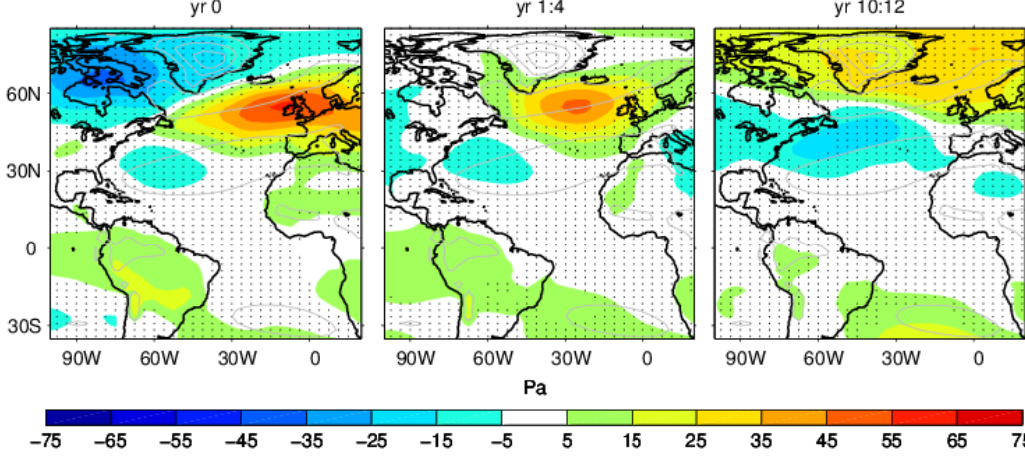
Fig. 8. Composites of annual mean anomalous sea level pressure in phase with the volcanic eruption (left) and following the volcanic eruption (other panels) for the period after 1400 A.D. Grey contours show the SLP annual mean in the model (contour interval is 10 2 Pa) .